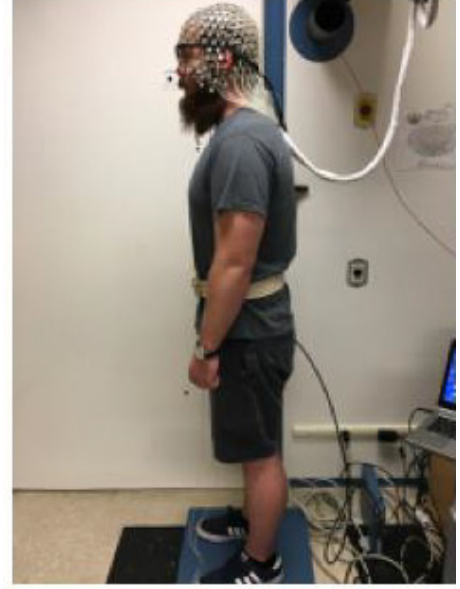
Figure 1. Experimental protocol for standing with eyes open. The person pictured provided informed consent for publication of the image.